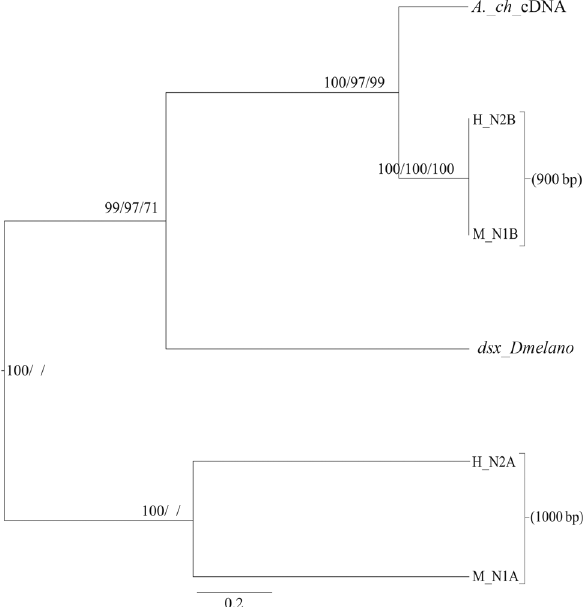
Figure 5 - Tree topology generated using the HKY85 model of molecular evolution based on male (M N1A and MN1B) and female (H N2A and H N2B) genomes, on the expressed partial sex-specific cDNA sequence iso- lated from Austrolebias charrua ( A.ch cDNA) and the dsx_ D. melanogaster sequence. Bayesian phylogeographic inference framework implementedinBEAST1.5.4v.Numbersabovethebranches(lefttoright) correspond to the Bayesian posterior probability for clades obtained using BEAST 1.5.4v , followed by ML and MP boostrap support (> 60%) re- spectively, recovered in 1000